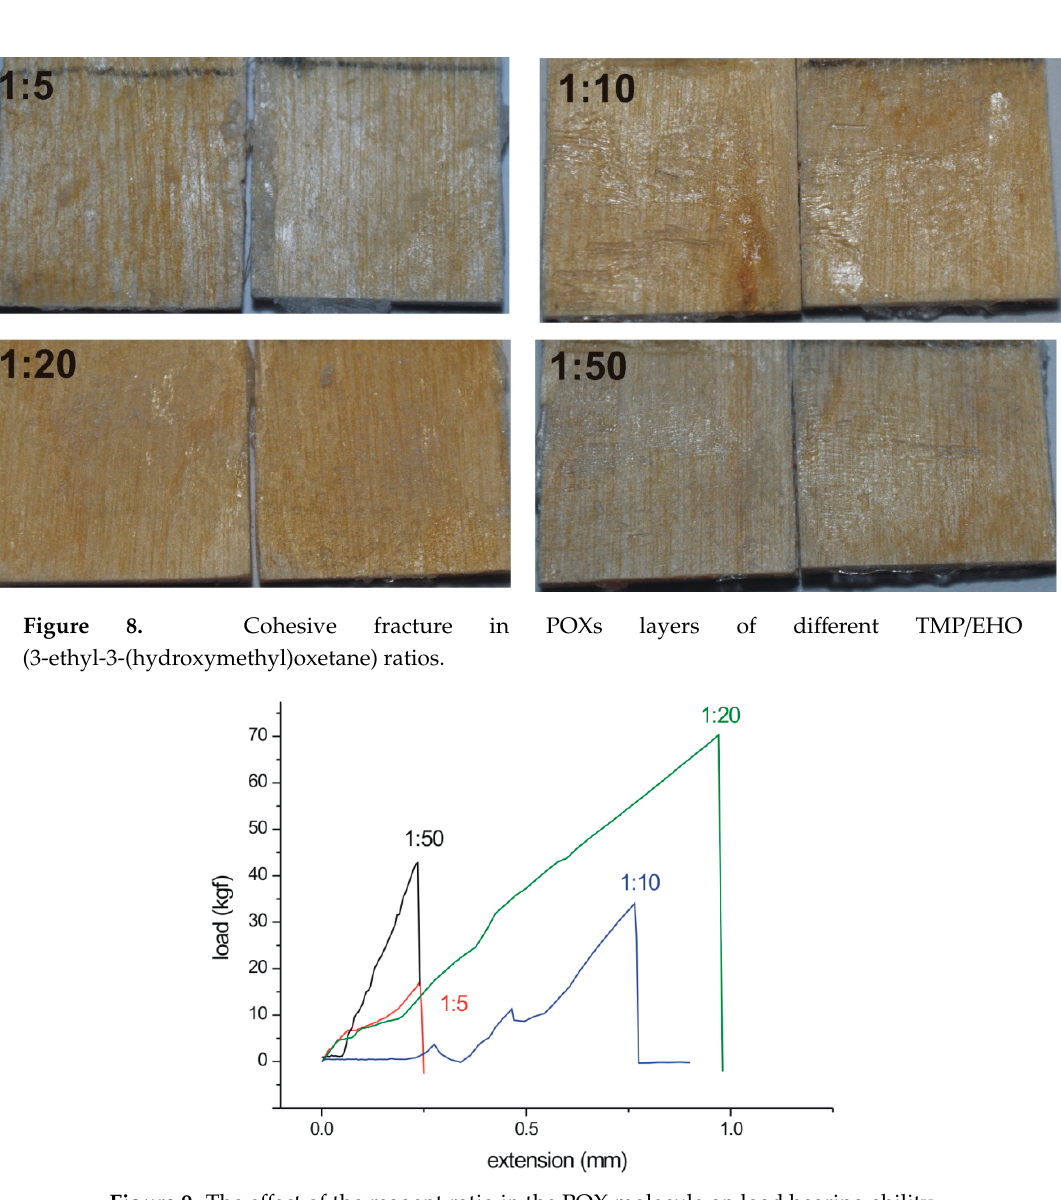
Figure 9. The e ff ect of the reagent ratio in the POX molecule on load bearing Figure 9. The effect of the reagent ratio in the POX molecule on load bearing ability. Table 3. Selected thermal and surface properties of the studied POXs.